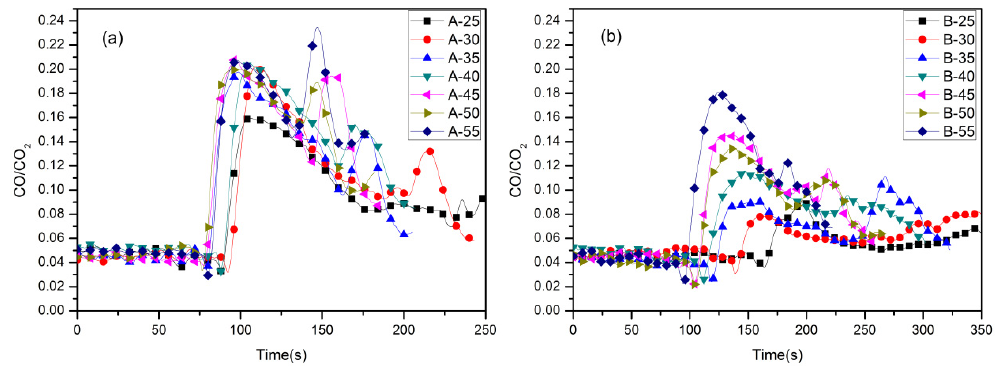
Materials 2016 , 9 , 168 Figure 10. CO/CO 2 ratio in relation to heat flux. ( a ) aluminum ‐ polyurethane; ( b ) pure polyurethane.